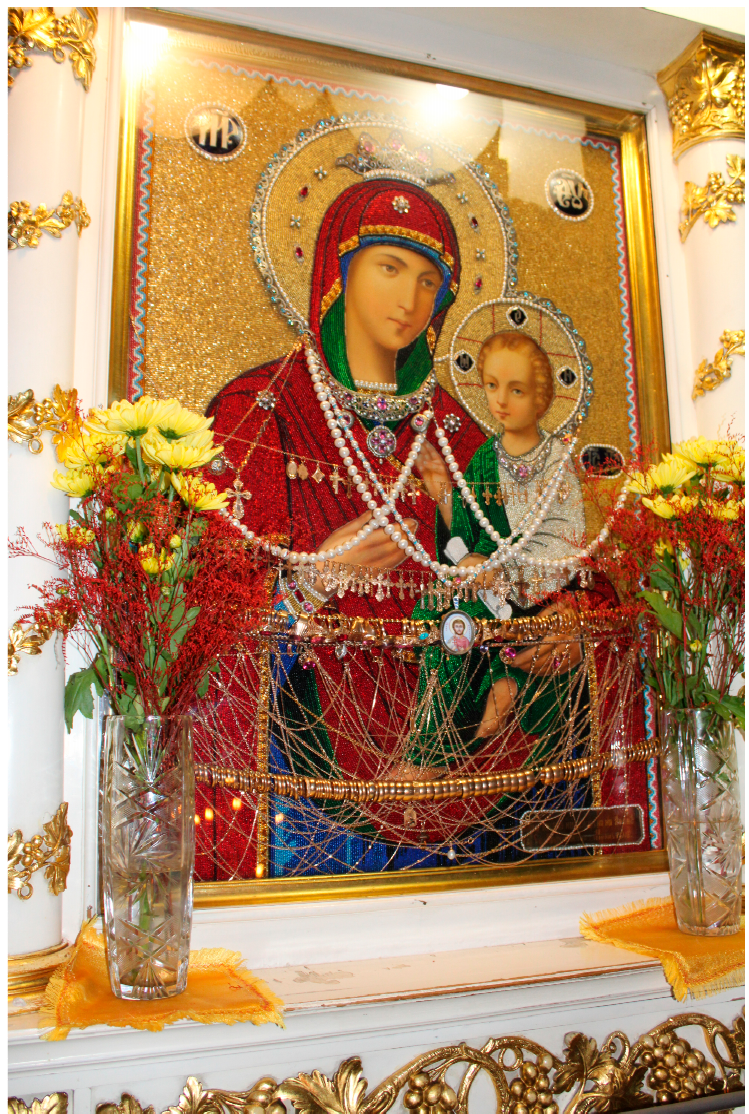
Figure 2. “She Who is Quick to Hear” ( Skoroposlushnitsa ), Krestovozdvizhenskiy church, Petrozavodsk, Russian Karelia (photo by authors).